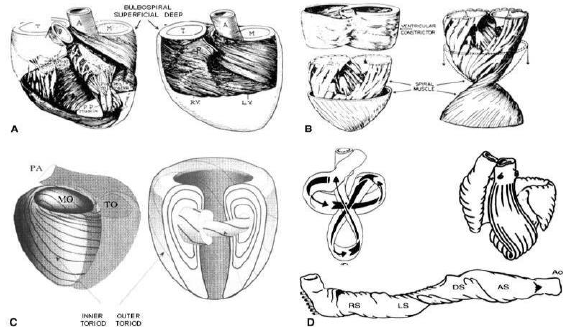
Figure 1. Examples of some models of myocardial fiber organization. A, Robb and Robb model. B, Rushmer's conceptual model. C, Streeter's LV model. D, Torrent Guasp